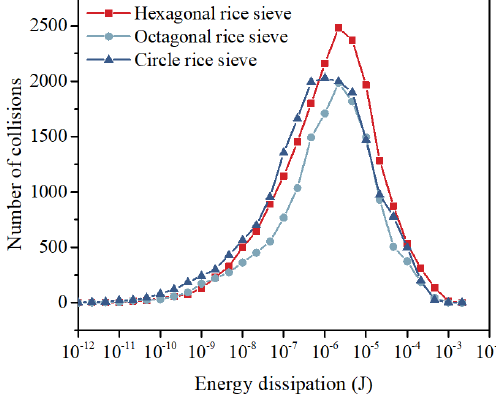
Figure 8. The distribution of energy dissipation during the particle